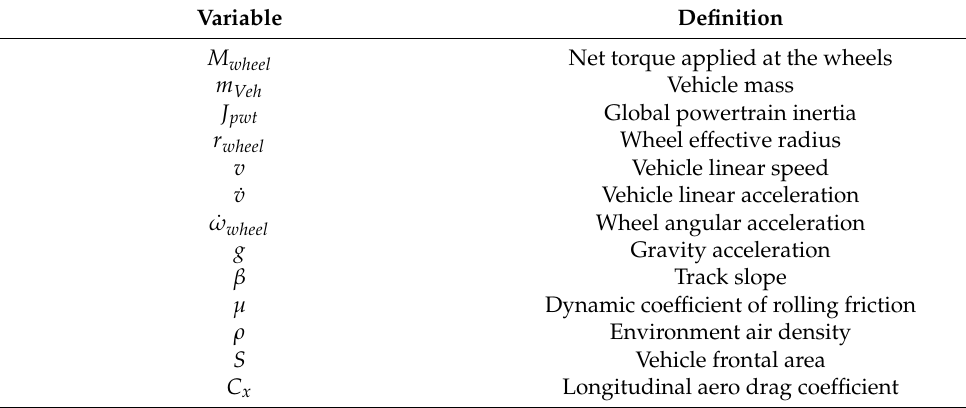
Table 3. Variable definitions of Equation (17)